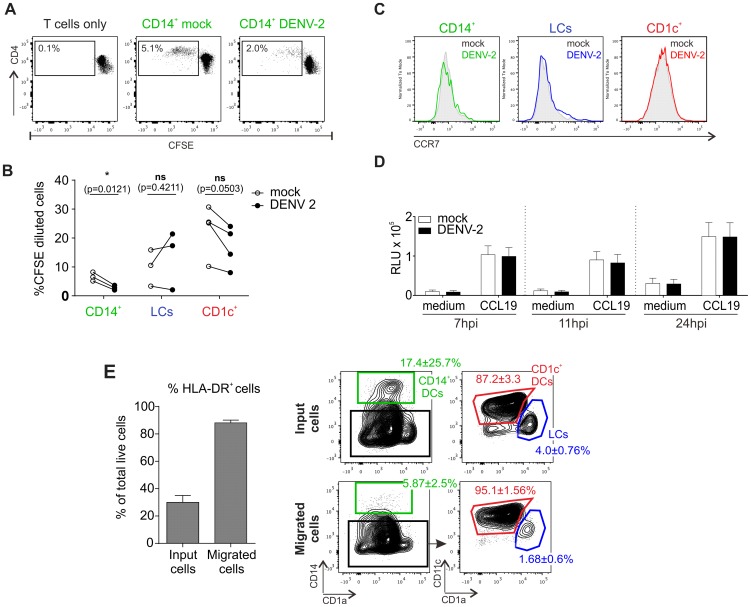
T cell stimulation capacity of DENV-exposed DC subsets and their migratory response towards the chemokine CCL19.(A) Co-culture of sorted infected DCs with allogeneic, CFSE labeled CD3+ T cells (ratio 1∶10). Proliferation was measured after 5 days by flow cytometry, one representative result for CD14+ dermal DCs is shown. (B) Summary data from all three susceptible DC subsets are shown, each line represents one donor. Statistical analysis was performed using paired two-sided t-test, *p<0.05; ns, not significant, p-values are indicated for each DC subset (C) CCR7 expression on non-treated and DENV-2-exposed DCs at 24 hpi. One representative experiment of three is shown. (D) Skin cell migration was assessed using a 5 µm pore-sized membrane (see Methods Section) with either medium alone or CCL19 (20 ng/ml) in the bottom chamber. Cells were allowed to migrate for 2 h at 37°C before CellTiter Glo activity was measured (RLU, relative light units). Composite data of 4–6 donors is shown, mean ± SEM from 4 independent experiments. (E) Whole skin cells were analyzed by flow cytometry before and after migration towards CCL19. Migrated cells (in the lower well of the chemotaxis plate) were enriched in HLA-DR+ cells compared to input cells (left graph). Migrated HLA-DR+ cells were enriched in CD1c+ DCs and LCs, but not CD14+ DCs (right graph; non-infected cells are illustrated; similar results were obtained for infected cells). n = 3 donors, mean ± SEM from three individual experiments.